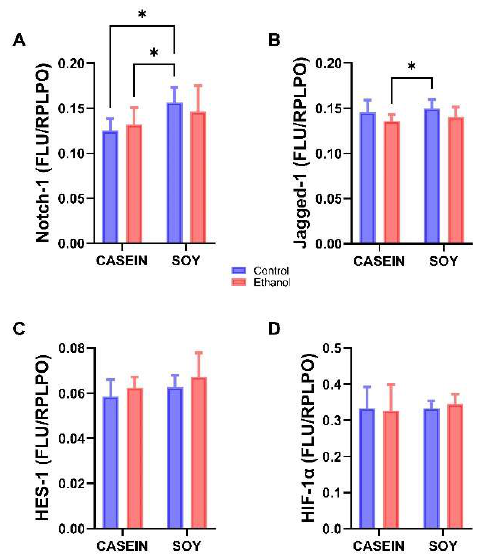
Figure 5. Effects of chronic ethanol and dietary soy isolate on ASPH protein expression. Duplex ELISAs were used to measure ( A ) ASPH using the A85G5 monoclonal antibody, and ( B ) Humbug + ASPH using the A85E6 monoclonal antibody. Immunoreactivity was detected with horseradish peroxidase-conjugated secondary antibody and Amplex UltraRed soluble fluorophore. Results were normalized to large acidic ribosomal protein (RPLPO) (See Methods). Graphed data reflect the mean ± S.D. of immunoreactivity and were analyzed with two-way ANOVA tests (Table 5) and post hoc Tukey tests. (dFn, dFd = 1, 40 for interaction; 1, 40 for sex; 1, 40 for exposure-ethanol/protein). Significant P-Values are indicated above the bars. * p < 0.05; ** p < 0.01; *** p < 0.001; **** p < 0.0001; ns = not significant. Table 5. Ethanol and Dietary Protein Effects on ASPH and Notch Pathway Proteins.